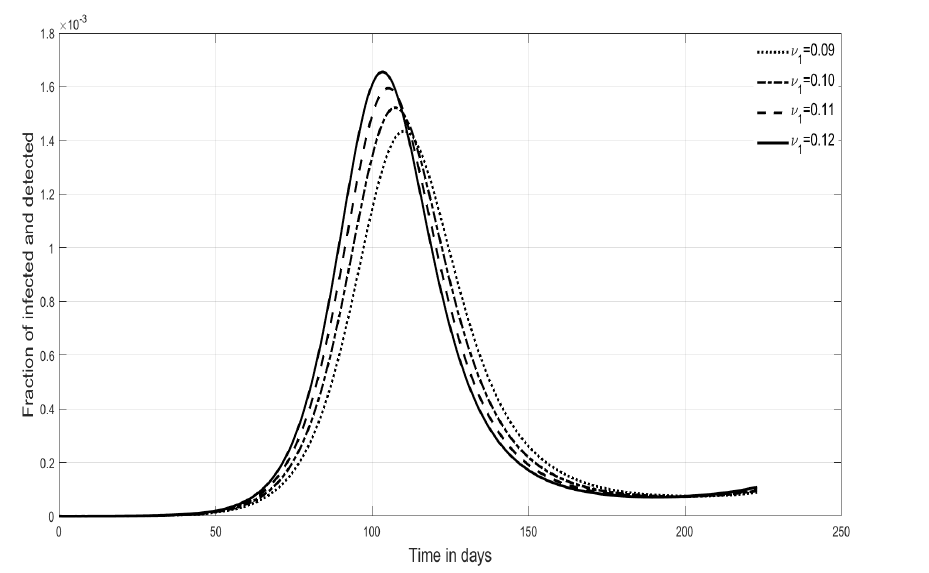
Figure 3. Shows the effects of varying ν 1 of the fraction of detected cases.